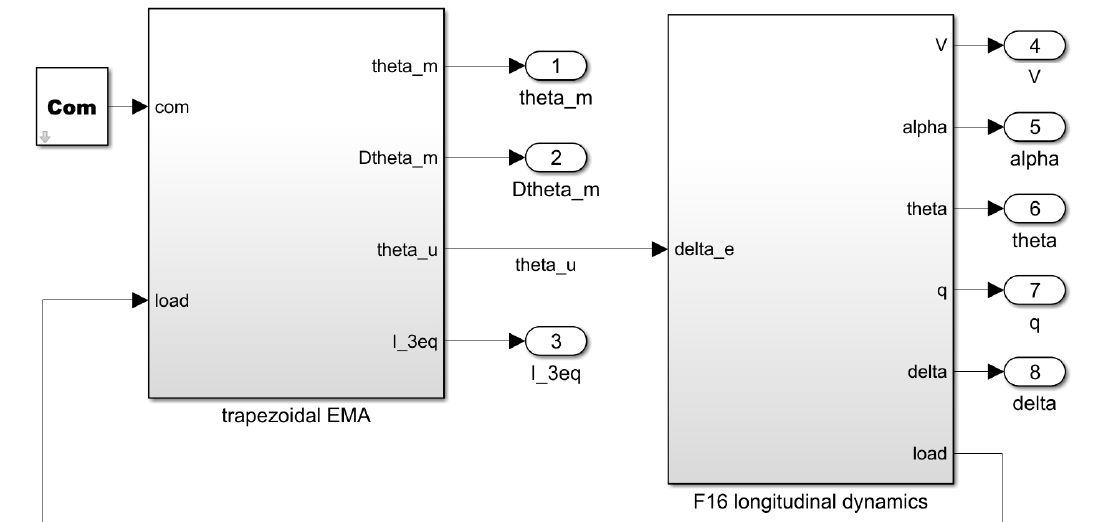
Figure 2. Model overview